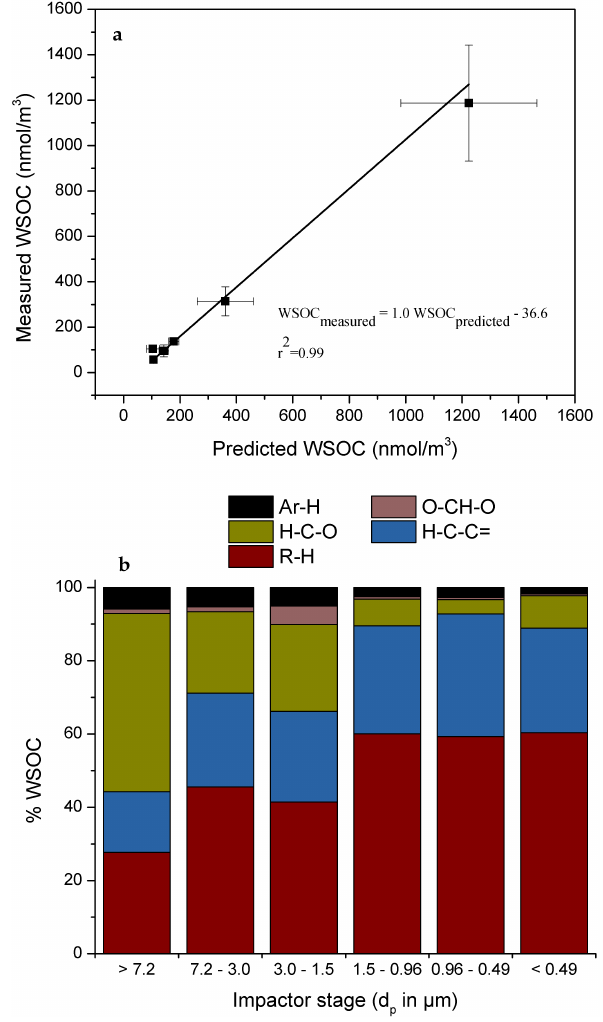
Figure 7. Measured and predicted WSOC concentrations (a) and contributions of R–H, H–C–C = , H–C–O, O–CH–O and Ar–H on WSOC (b) for each impactor stage of urban